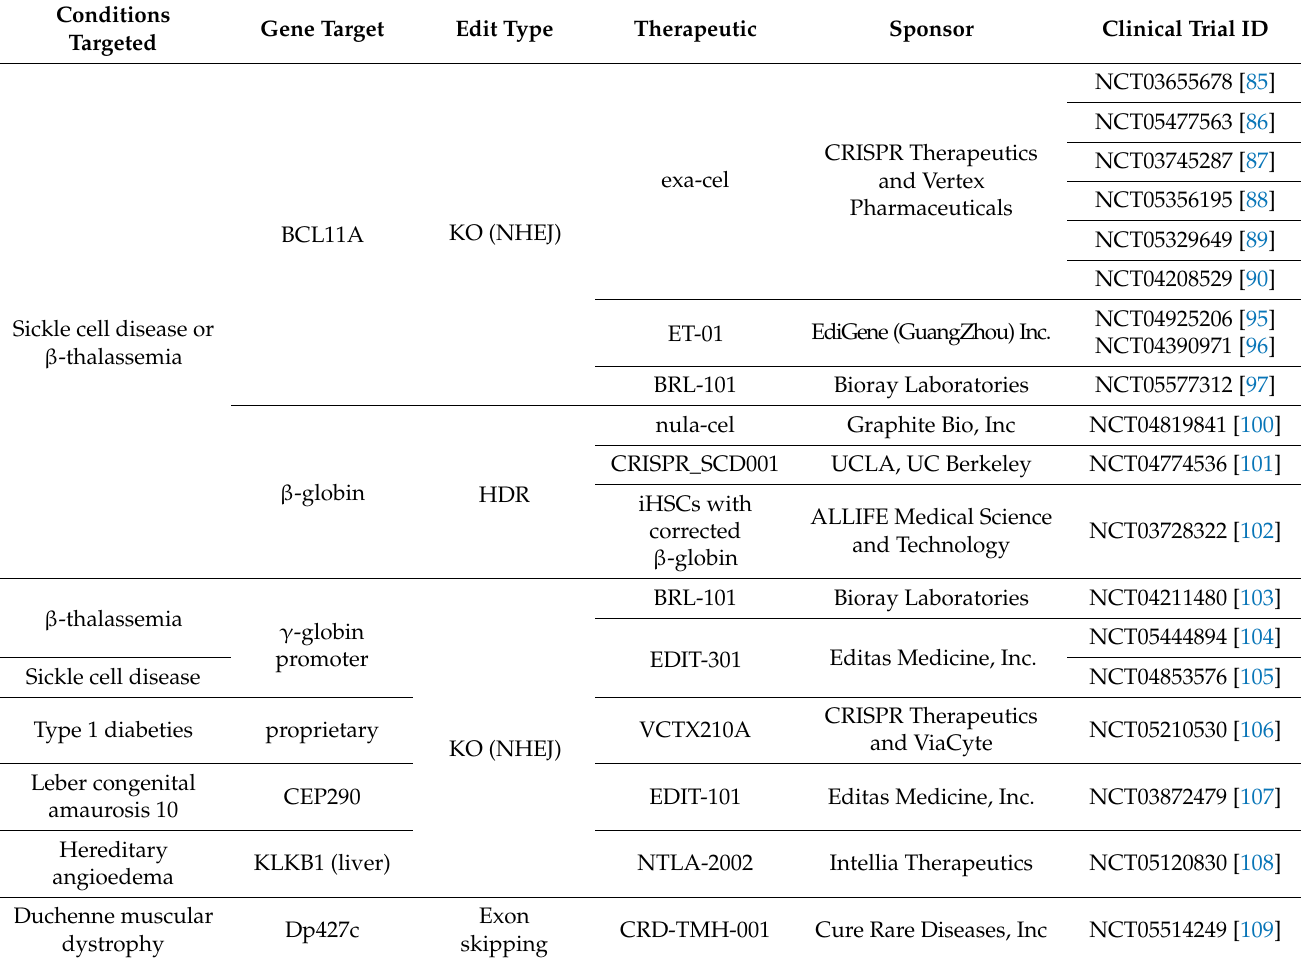
Table 3. List of CRISPR-Cas9-based gene editing therapies for other non-infectious